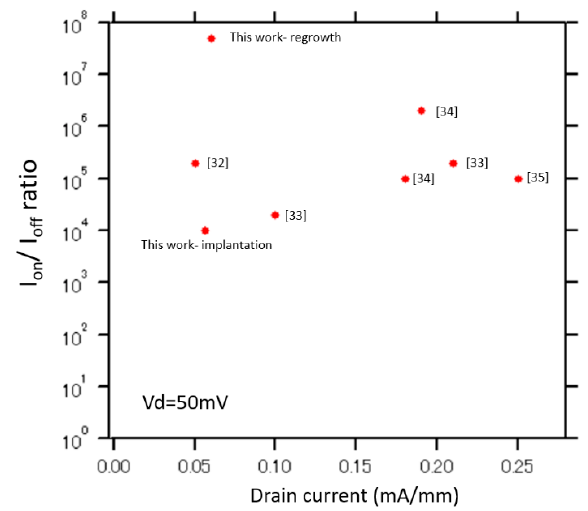
Figure 6. Comparison of transconductances (a) and threshold voltages (b) extracted from Y-function of two types of MOSFETs.